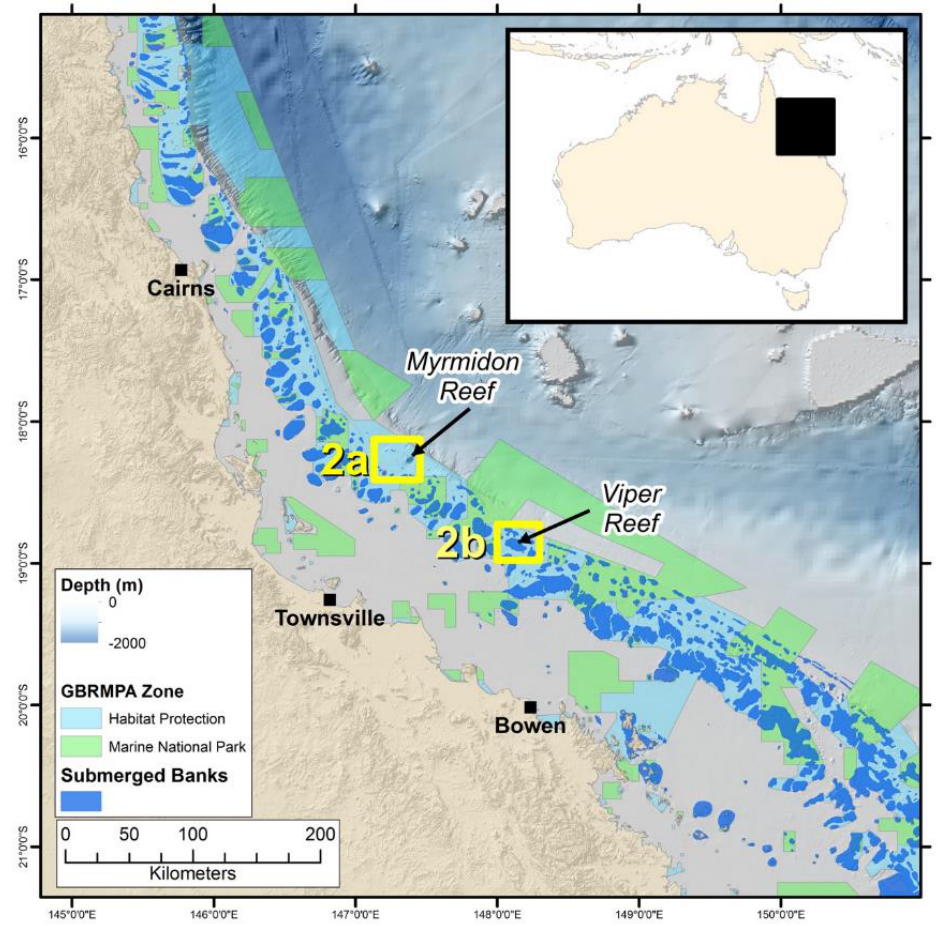
Figure 1. Map showing shelf-break areas of the central Great Barrier Reef sampled: ( a ) Myrmidon Reef, Northern Submerged Shoals, an inter-reefal transect, and ( b ) Viper Reef. The shelf-break is over 100 km offshore and the adjacent continental slope drops off to depths of hundreds of meters. Within the Great Barrier Reef Mark Park, activities are managed by the Great Barrier Reef Marine Park Authority (GBRMPA) in Zones. Marine National Park Zones (green) are ‘no-take’ areas where extractive activities such as fishing and collecting are not allowed without a permit. Habitat Protection Zones (blue) are set aside to protect habitats from potentially damaging activities. See Fernandes et al., 2005 for a description of the zonation. Submerged banks from Harris et al., 2013 are depicted in darker blue.